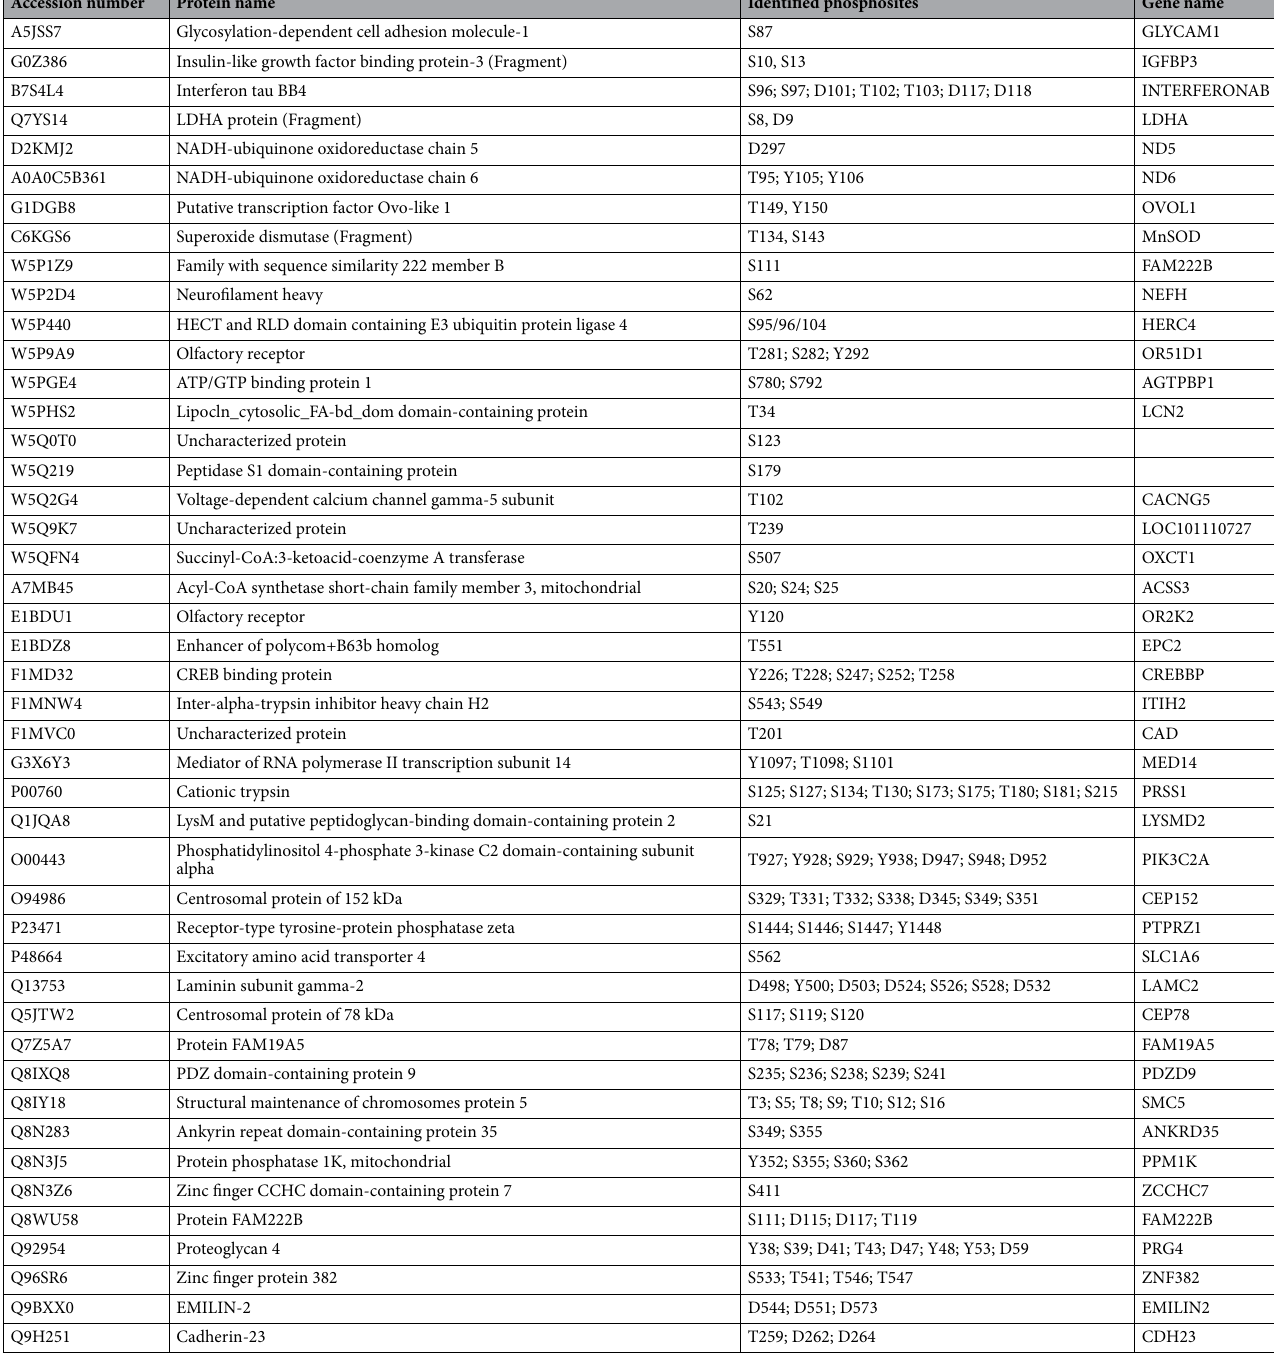
Table 3. Phosphorylation in low abundance proteins of goat milk identified in the reference database with accession number and gene